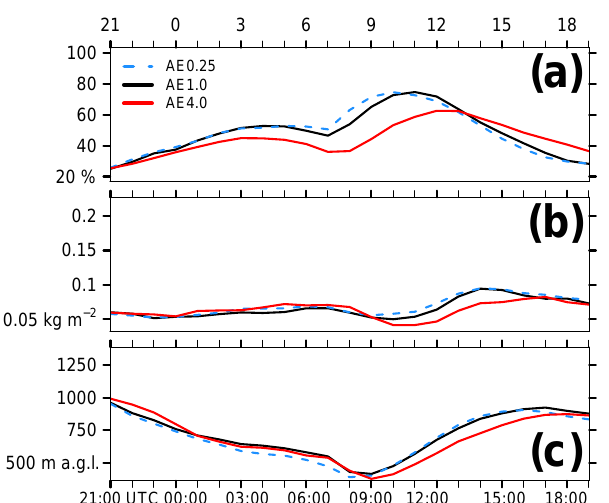
Figure E1. Spatial average (8 ◦ W–3.5 ◦ E, 5–10 ◦ N) of (a) cloud cover (%), (b) cloud water (kgm − 2 ) and (c) cloud base height (ma.g.l.) for the temporal evolution between 2 July 21:00UTC and 3 July 19:00UTC with respect to clouds below 1500ma.g.l.. The cloud cover is detected by nonzero values of cloud water. A value of 60% denotes that 60% of the domain is covered by clouds. For the spatial average of cloud water, values below 10gm − 2 are omitted. The cloud base height is detected via the lowest height above ground level with a nonzero cloud water value. The blue dashed, black solid and red solid lines denote the clean, reference and polluted case,